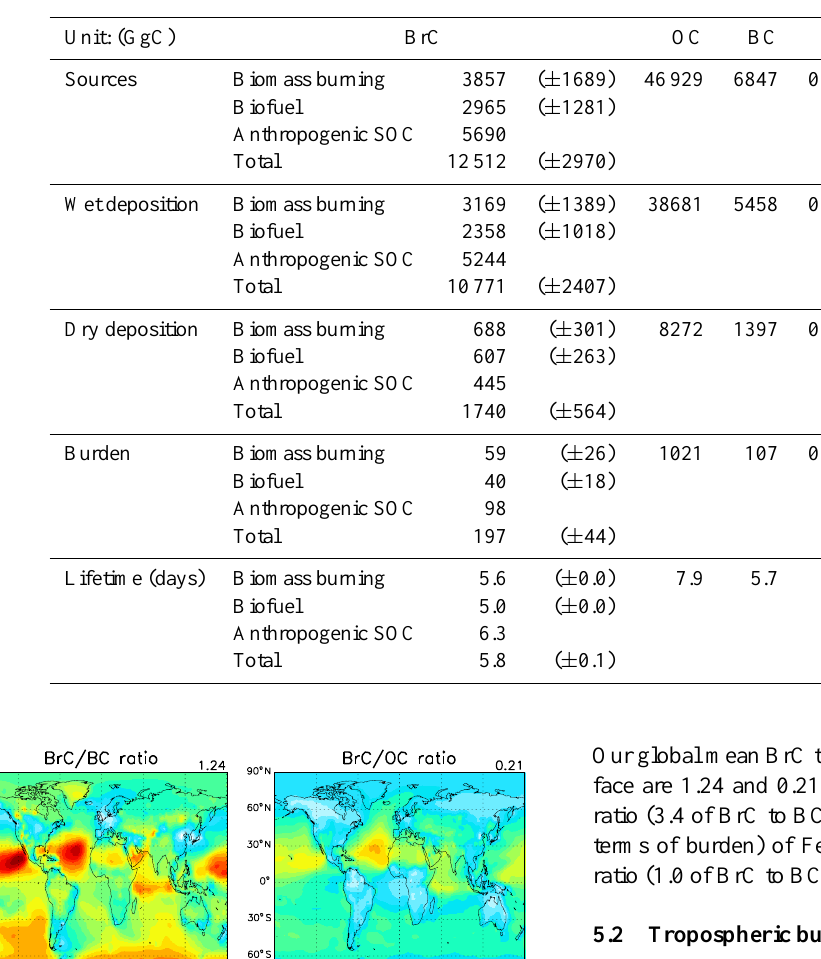
Table 3. Global tropospheric budgets of BrC compared to those of OC and BC. Uncertainties are indicated in the parentheses.